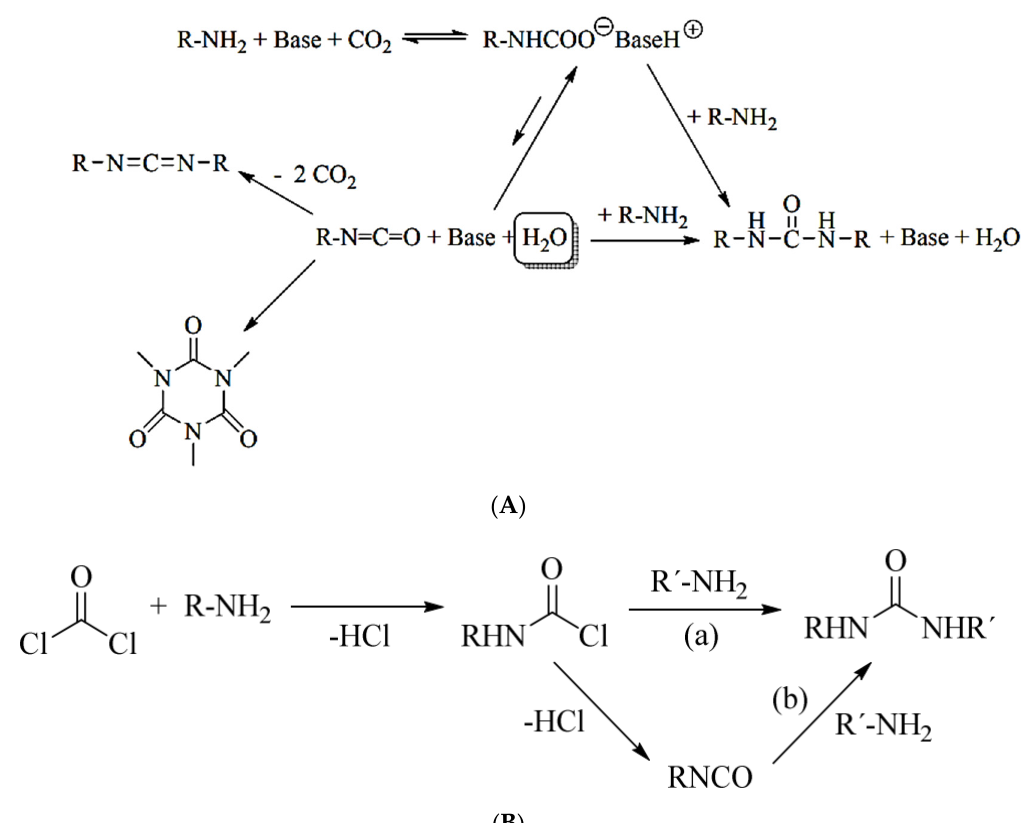
Figure 4. ( A ) Reaction pathways of a primary amine and CO 2 in presence of excess base. ( B ) Synthesis of urea derivatives: direct ( a ) and indirect ( b ) method. From reference [31].